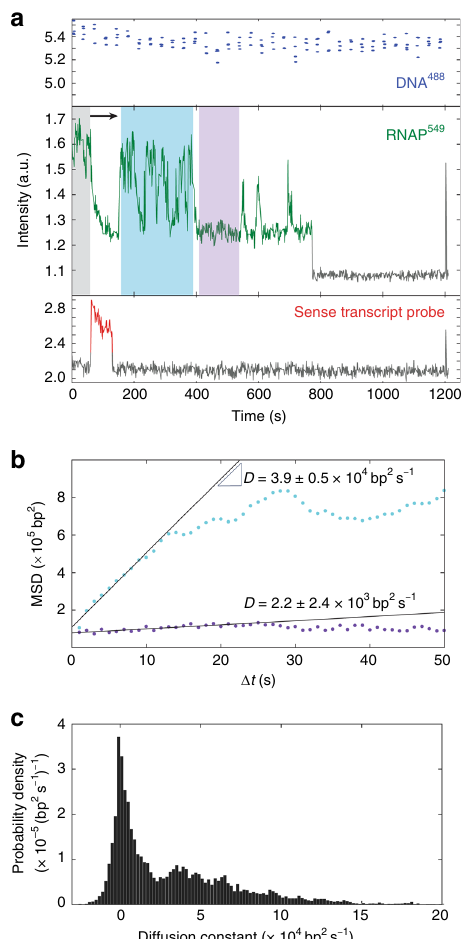
Fig. 2 RNAP can diffuse along DNA after termination. a A single-molecule emission record, as in Fig. 1c, for a different DNA spot location. Gray, teal, and purple highlight time intervals of high RNAP 549 fl uorescence before detection of transcript probe and post-termination intervals of fl uctuating and low fl uorescence, respectively. b Mean squared displacement (MSD) of RNAP 549 position on DNA during the teal and purple intervals in ( a ). Linear fi ts to the fi rst ten points of each MSD curve yield the effective diffusion coef fi cients over 10 s intervals, D . c Normalized histogram of D values measured separately for every 50 s window in n = 41 recordings of RNAP 549 retained on DNA after termination (13,522 windows